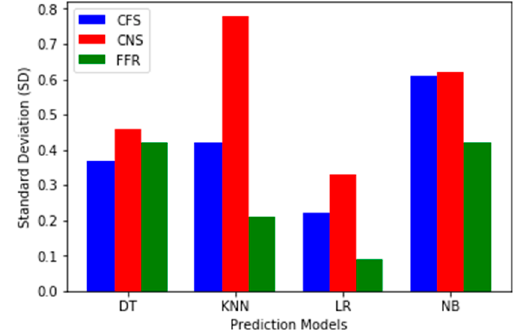
Figure 2. Average Accuracy for Prediction Models.